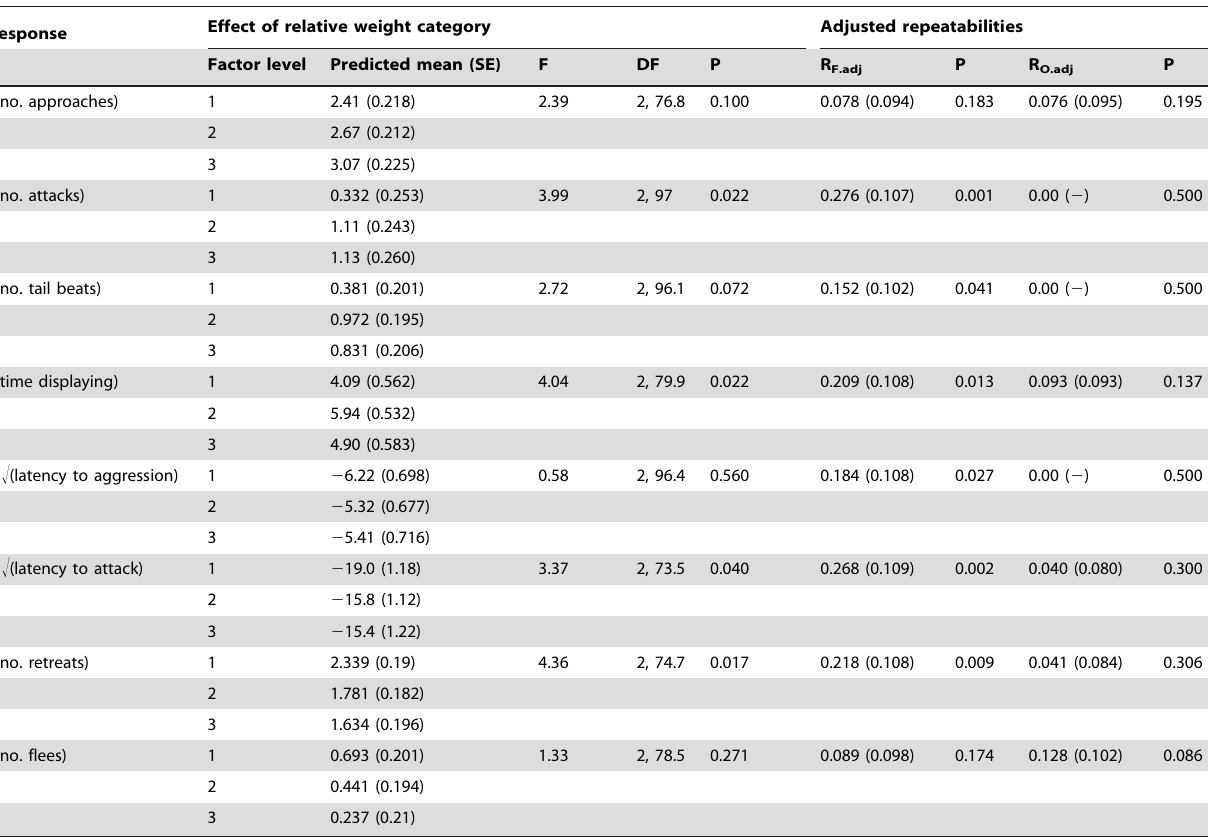
Table 4. Effect of relative weight class on focal behaviours in dyadic trials.